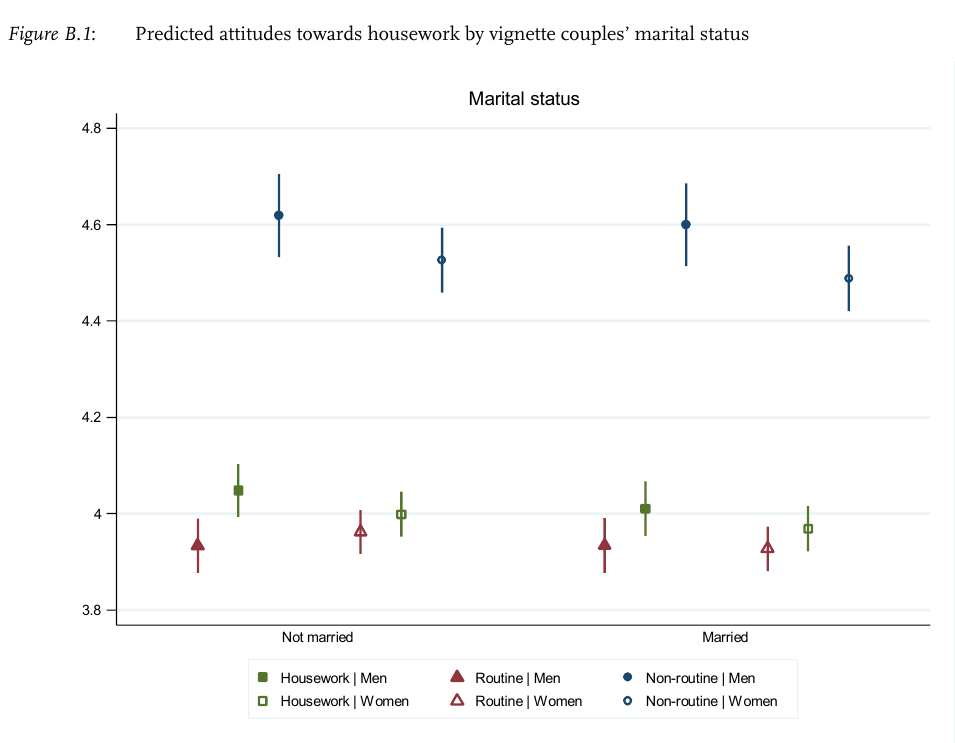
Figure B.1 : Predicted attitudes towards housework by vignette couples’ marital